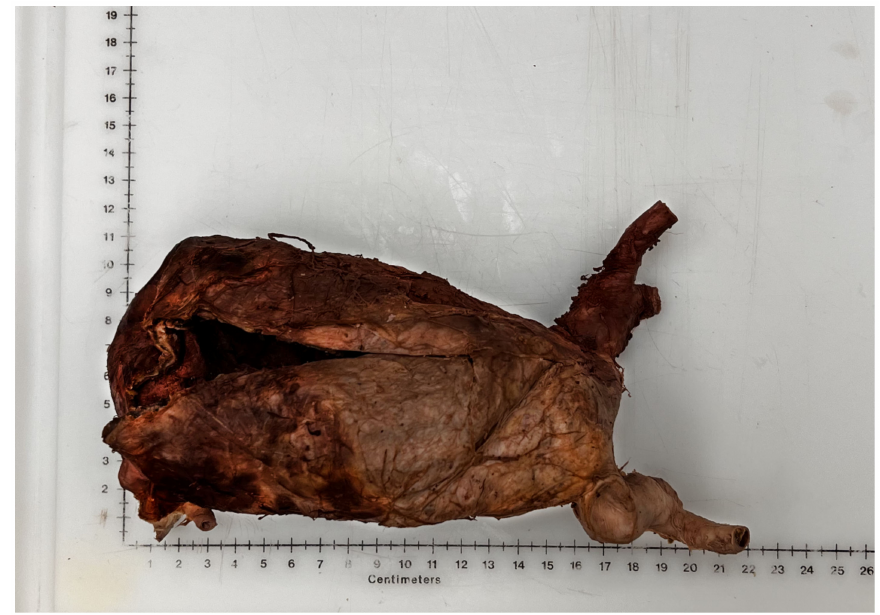
Figure 1. Measurement of the AAA: 8.5 cm by 17